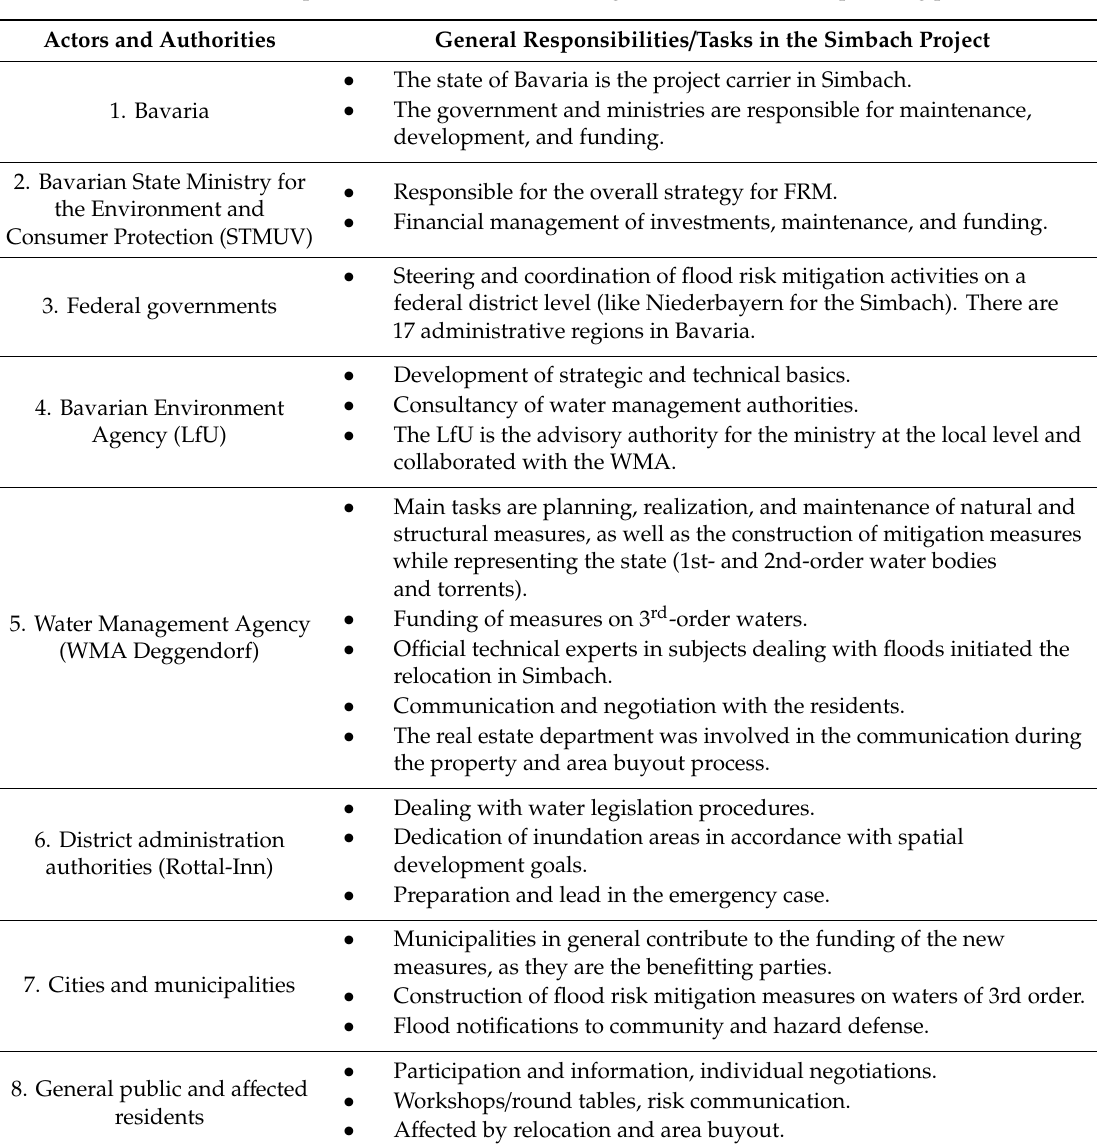
Table 1. Actors and responsibilities in flood risk management (FRM) and the planning